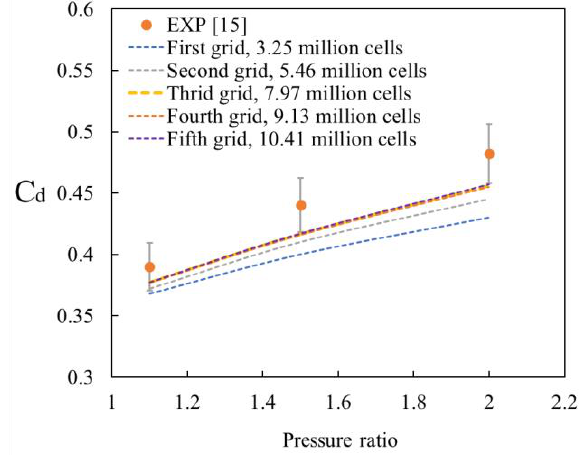
Figure 5. Grid sensitivity test of the Reynolds-Averaged Navier–Stokes (RANS) calculation for the effect of the pressure ratio on the discharge coefficient of the baseline labyrinth seal. Table 2. Specifications of mesh arrangements in the grid sensitivity test.